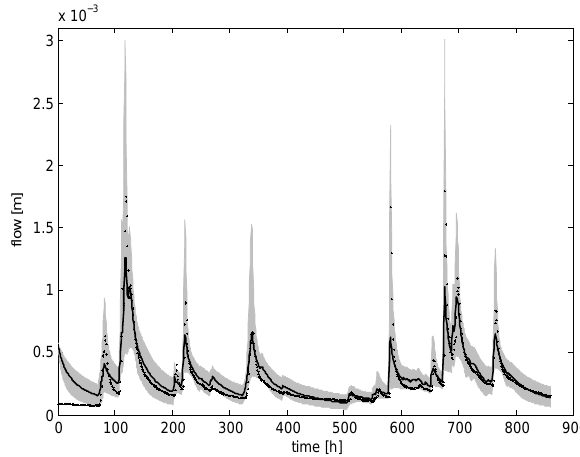
Fig. 7. Revised validation of the TOPMODEL, to reduce volatility of predictions, case (a): 76.6% of output variation explained; dots denote the observations, simulations (posterior mean) are marked by a solid black line, shaded area denotes 95% confidence bands. Surface flow partition: 3.5% of the overall